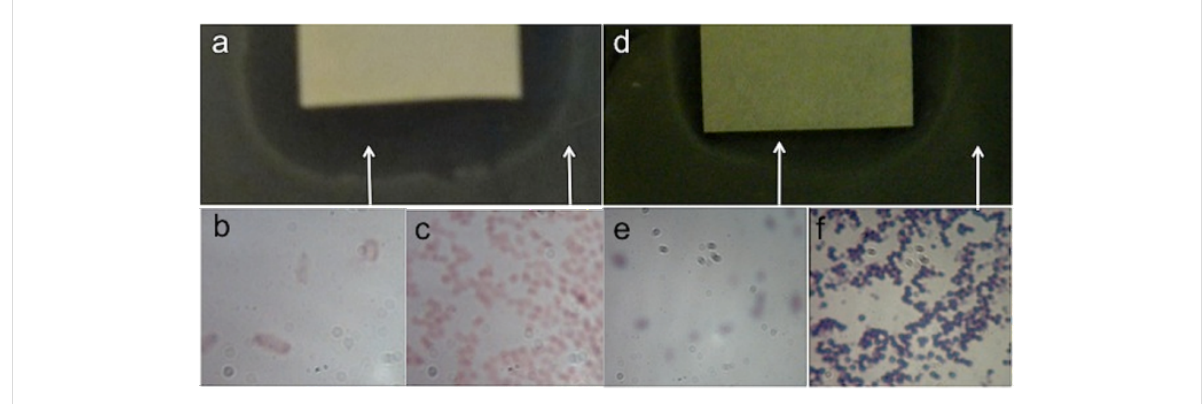
Figure 3: (a) Optical image of the zone of inhibition for E. coli ; (b) E. coli bacterial cells in the inhibition zone; (c) E. coli bacterial cells outside the inhi- bition zone; (d) optical image of the zone of inhibition for S. aureus ; (e) S. aureus bacterial cells in the inhibition zone; (f) S. aureus bacterial cells outside the inhibition zone.